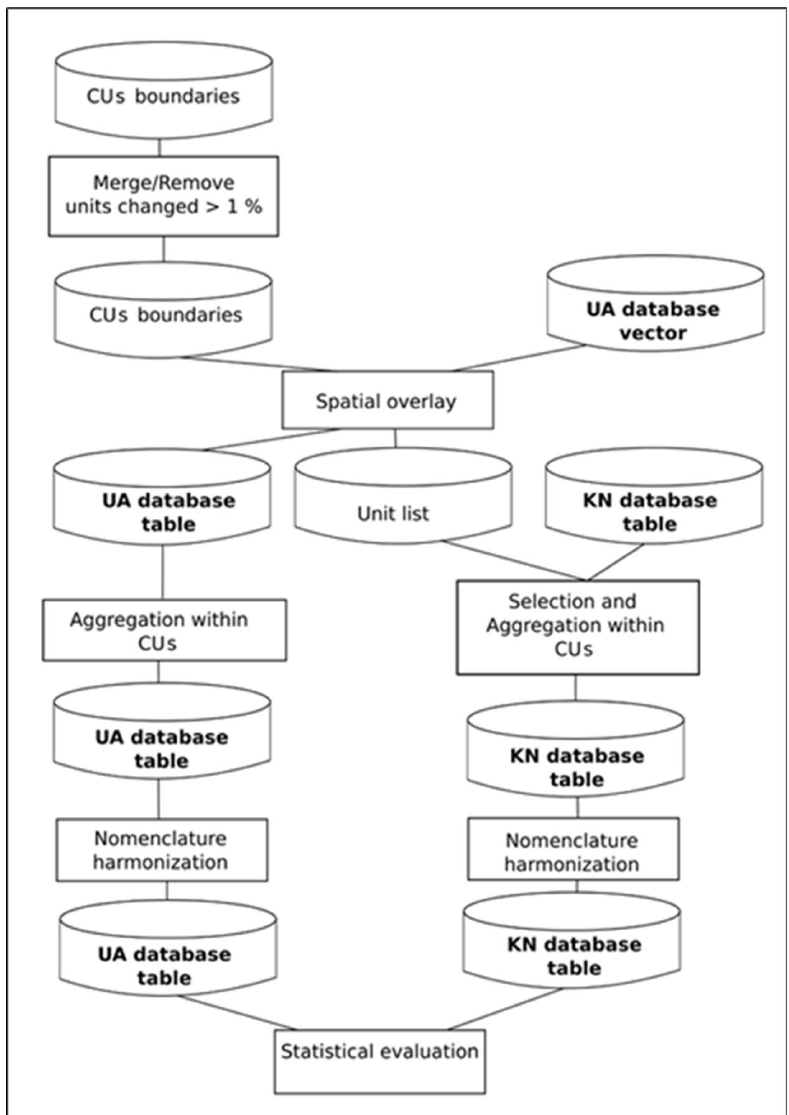
Figure 2. Flowcharts of the methodology used. CUs: cadastral units.